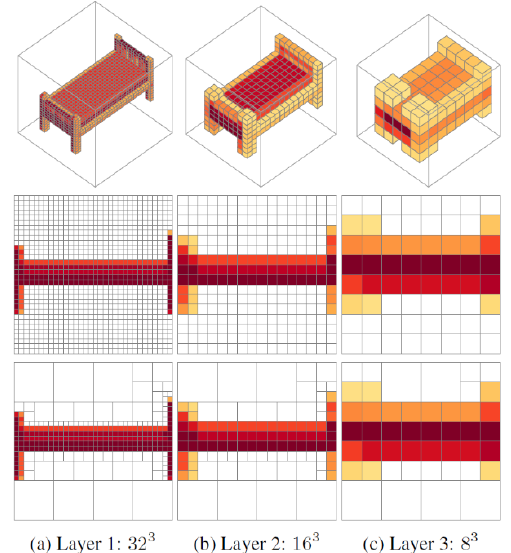
Figure 2. An object displayed in voxels in different resolutions (top row) once represented in a voxel grid (middle row) and once represented in a deep data structure (bottom row). Occupied cells are colored and indicate activation, while unoccupied are colored white. (Riegler et al., 2017)